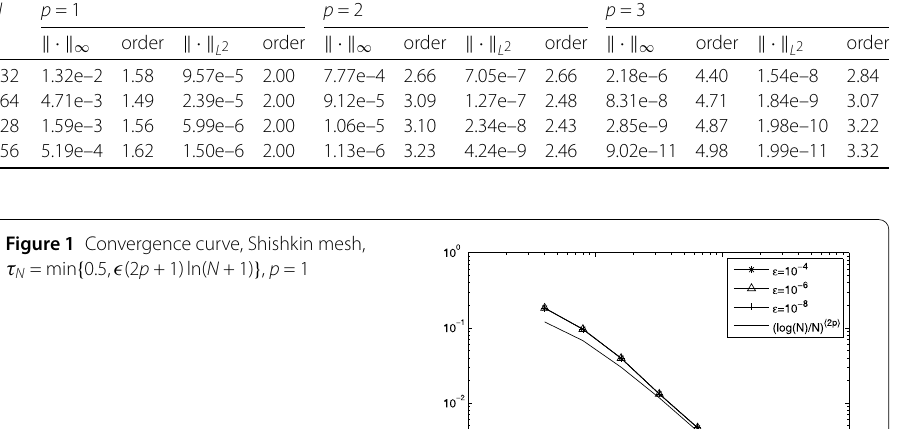
Table 2 Shishkin mesh, τ N = min { 0.5, (cid:2) (2 p + 1)ln( N + 1) } , (cid:2) = 10 –8